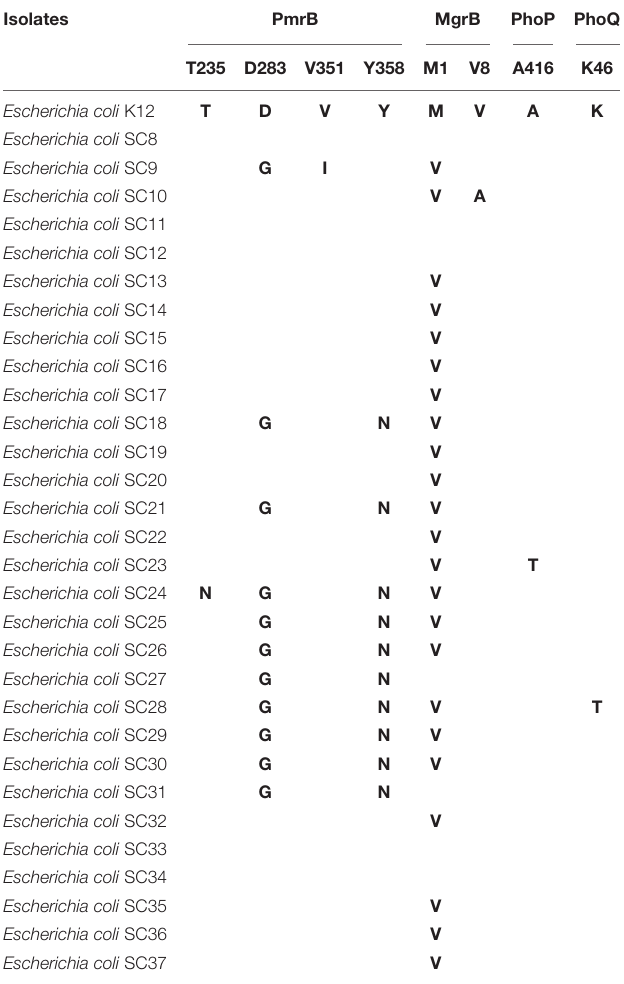
TABLE 3 | Mutations of PmrB , PhoP , and PhoQ in mc r-negative colistin-resistant E. coli isolates. Isolates